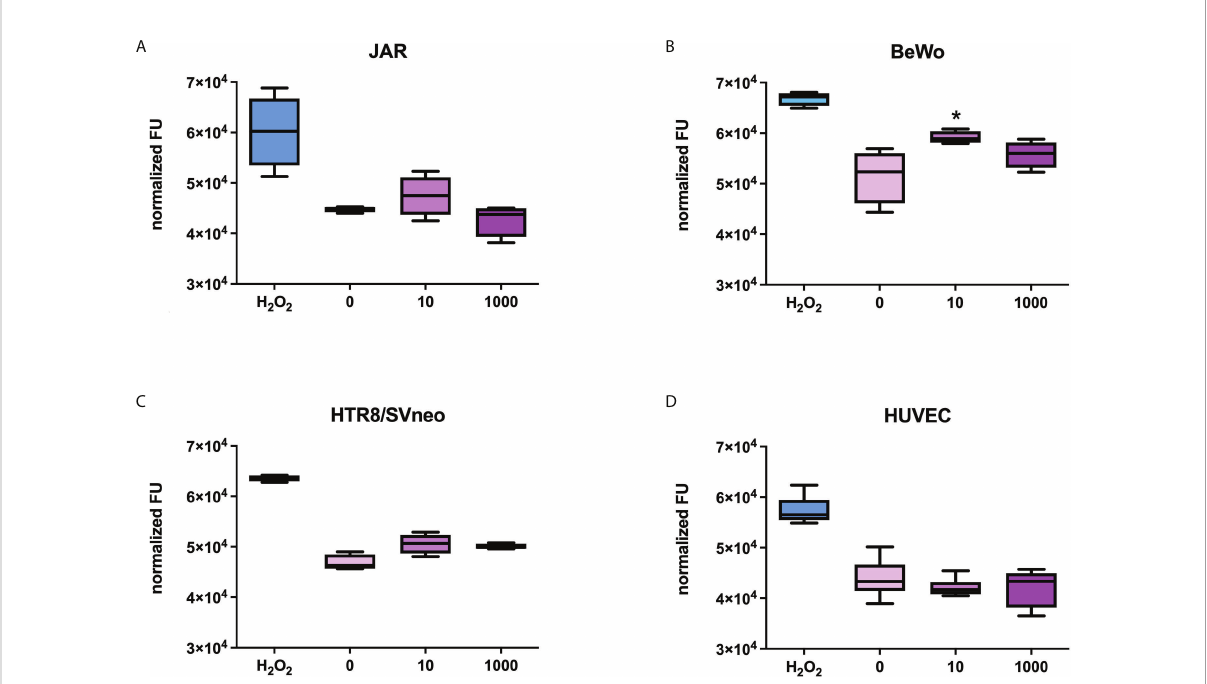
FIGURE 6 Evaluation of the proapoptotic effect of Spike S1 protein on placental cells. JAR (A) , BeWo (B) , HTR8/SVneo (C) or HUVECs (D) were grown to 80% con fl uence in 96-well plates and incubated with 10 ng/mL or 1000 ng/mL of Spike S1 protein. H 2 O 2 (0.5 µM) was used as a positive control. The cells were incubated with 5 µM of CellEvent Caspase-3/7 Green Detection Reagent. Fluorescence signals were normalized for the total proteins present in each well. For each group, the line in the middle of the box represents the median. The lower and the upper edges of the box indicate the 1 st and 3 rd quartile, respectively. Data are results from three independent experiments performed in triplicate. ∗ p < 0.05, as compared to untreated cells (Mann-Whitney test).